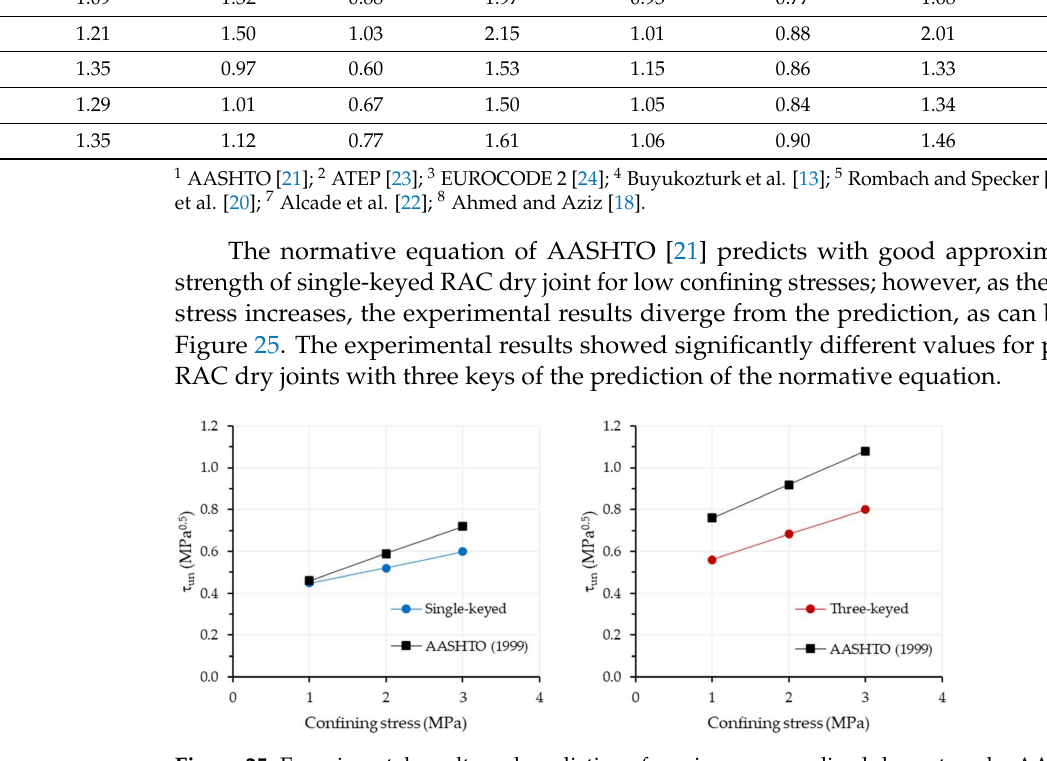
Figure 25. Experimental results and prediction of maximum normalized shear stress by AASHTO